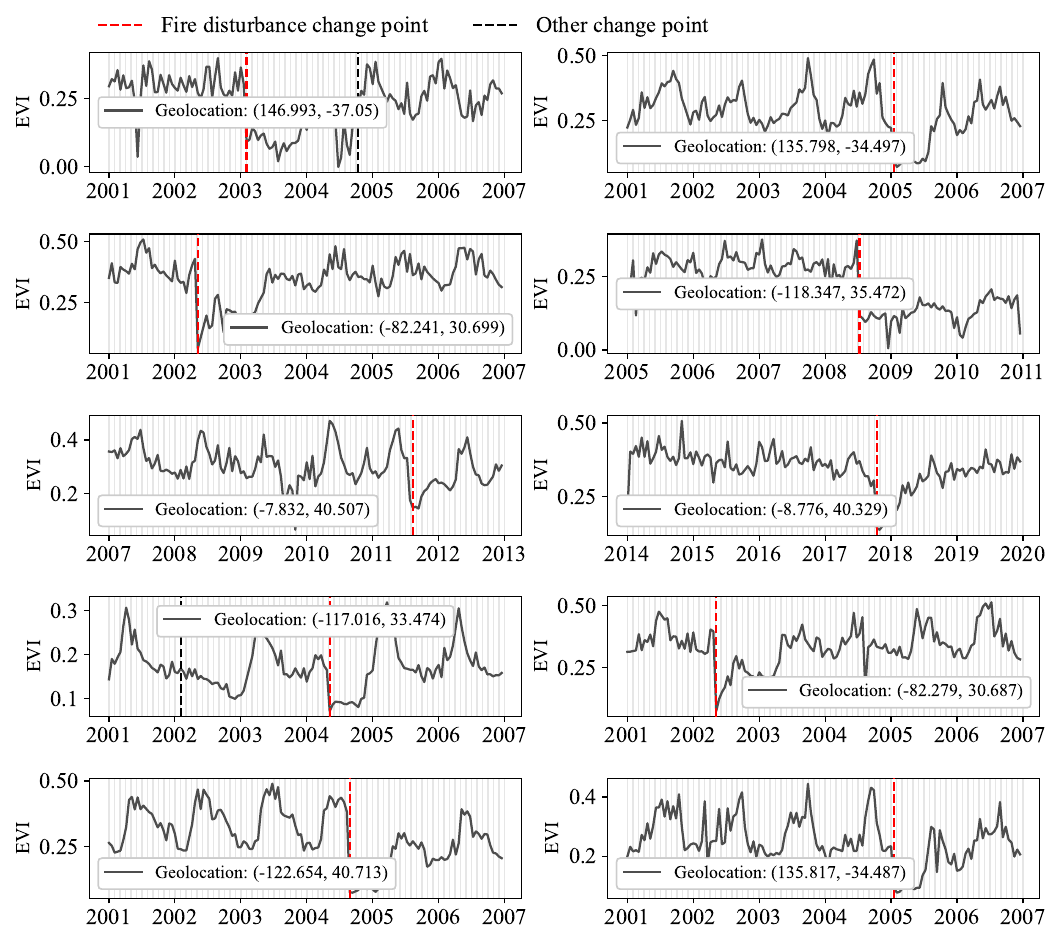
Figure 8. Partial time series change detection results for